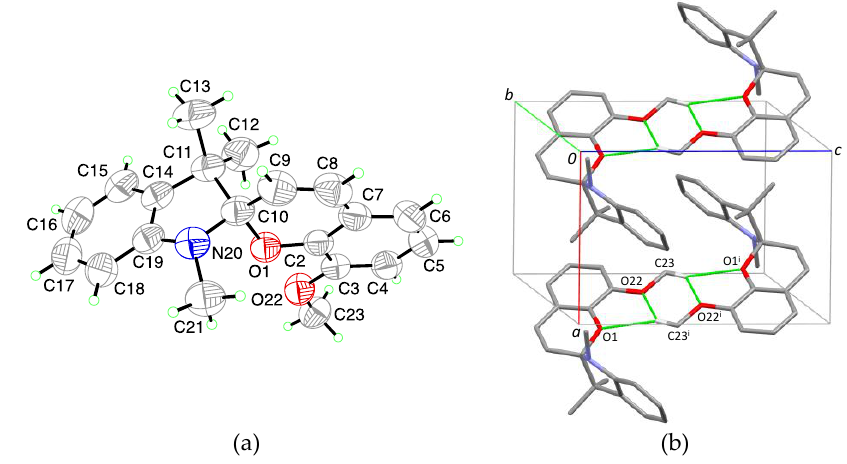
Figure 5. ( a ) A perspective view of (IVb), showing the atom-numbering scheme. Displacement ellipsoids are drawn at the 50% probability level. ( b ) A partial packing diagram for (IVb). Unique van- der-Waals interactions are indicated as green dashed lines. [Symmetry code: (i) − x, 1 − y, 1 − z].